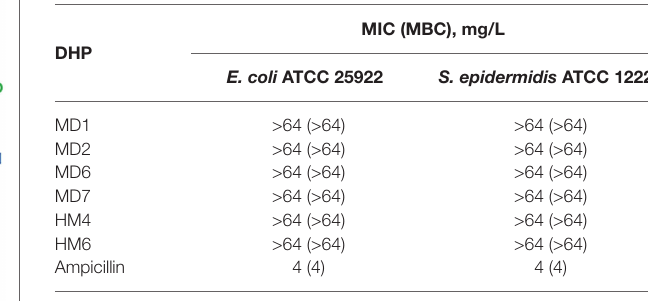
TABLE 2 | Antimicrobial activities of selected DHP-based HHQ derivatives against two representative species of the human normal